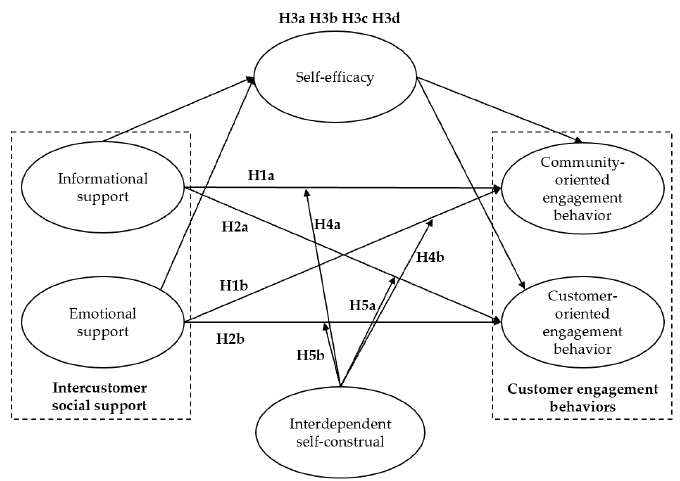
Figure 1. Research